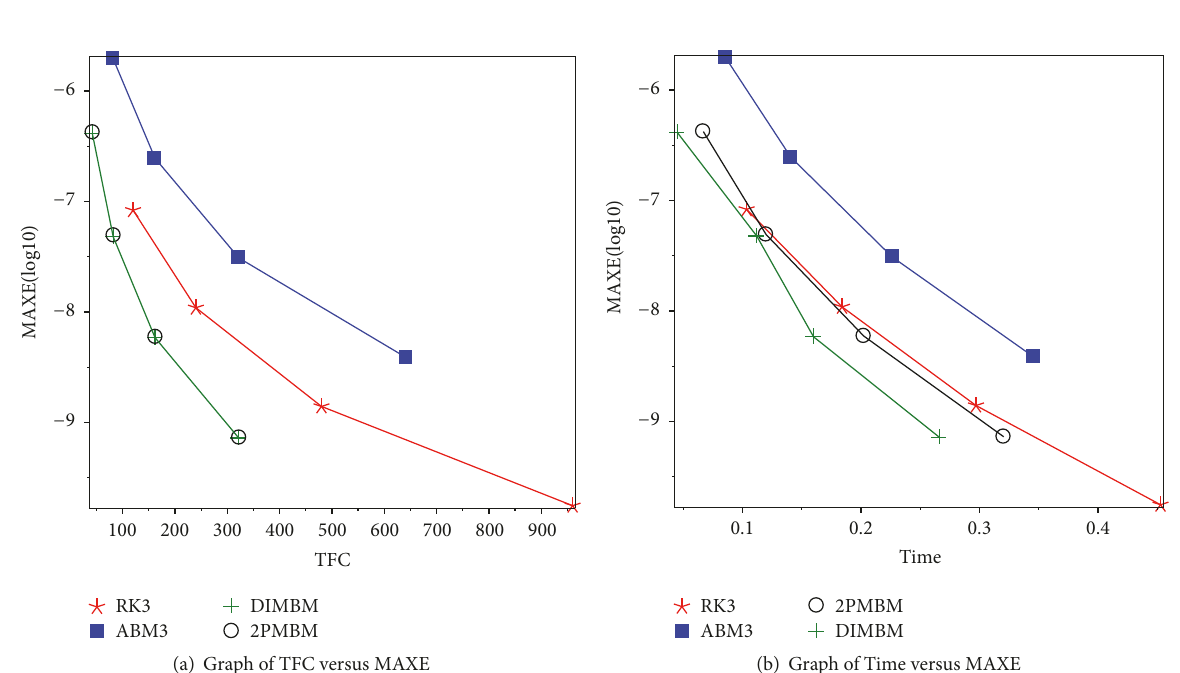
Figure 3: Graph of the numerical results when solving Example